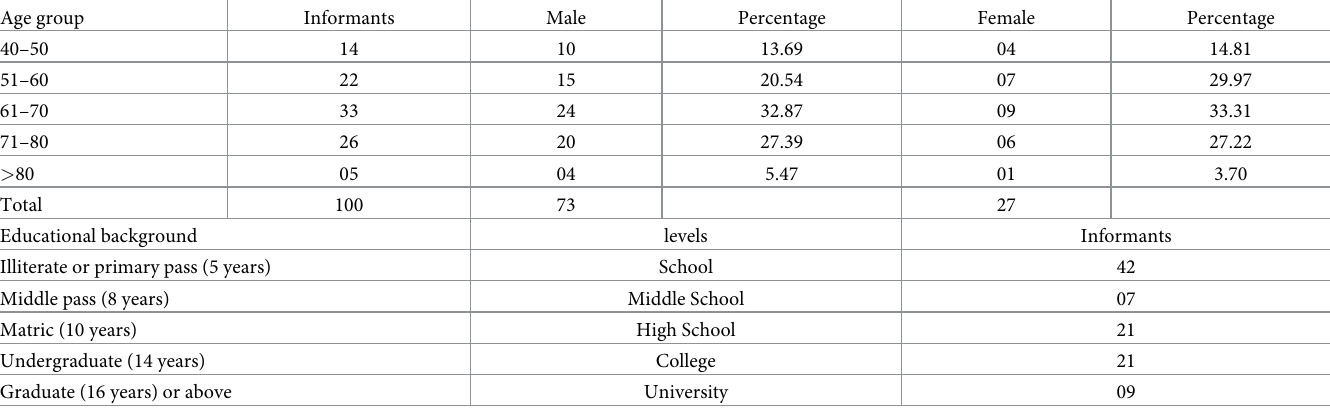
Table 1. Demographic data of informants recorded at Head